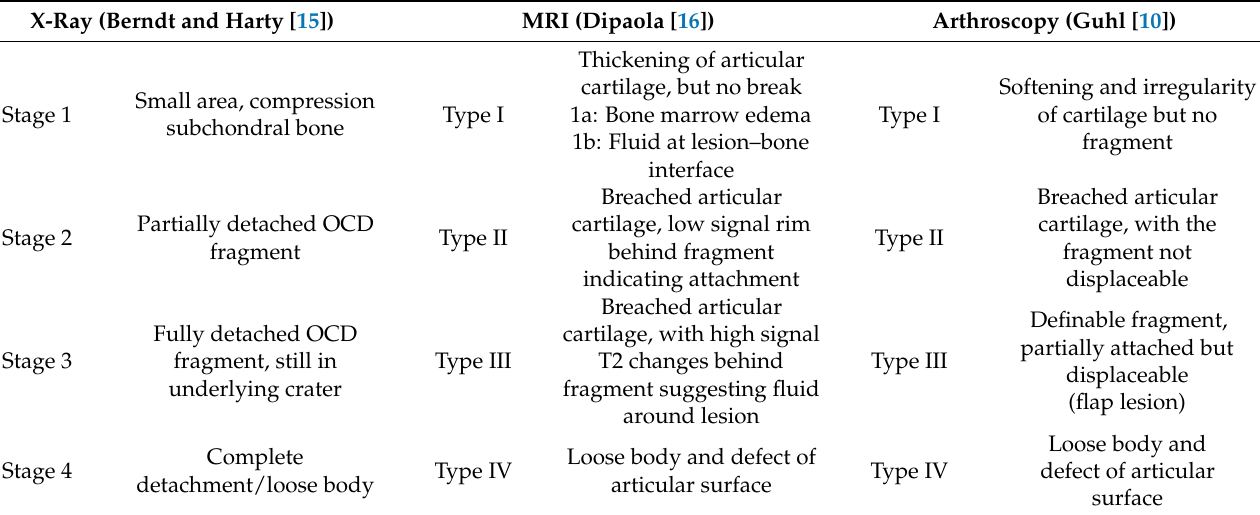
Table 1. Classification of osteochondritis dissecans (OCD)